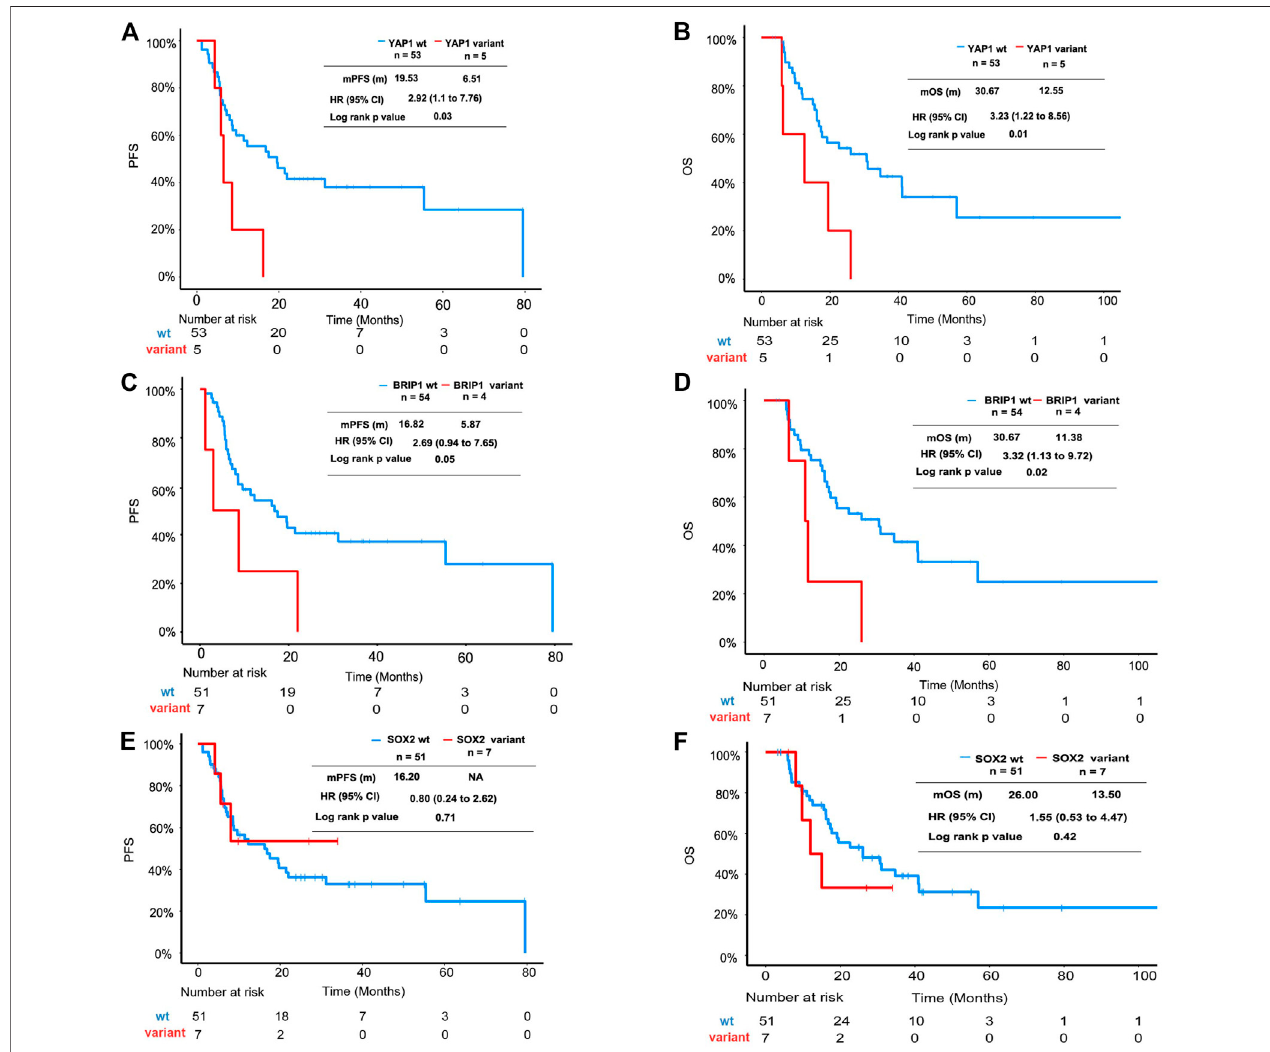
FIGURE 2 | Survival analysis of ESCC patients with YAP1 mutation, BRIP1 variation, and SOX2 mutation. (A) Kaplan – Meier plot showing PFS of the subgroup patients with YAP1 mutation versus patients without YAP1 mutation. (B) Kaplan – Meier plot showing OS of the subgroup patients with YAP1 mutation versus patients without YAP1 mutation. (C) Kaplan – Meier plot showing PFS of the subgroup patients with BRIP1 mutation versus patients without BRIP1 variation. (D) Kaplan – Meier plot showing OS of the subgroup patients with BRIP1 mutation versus patients without BRIP1 variation. (E) Kaplan – Meier plot showing PFS of the subgroup patients with SOX2 ampli fi cation versus patients without SOX2 mutation. (F) Kaplan – Meier plot showing OS of the subgroup patients with SOX2 ampli fi cation versus patients without SOX2